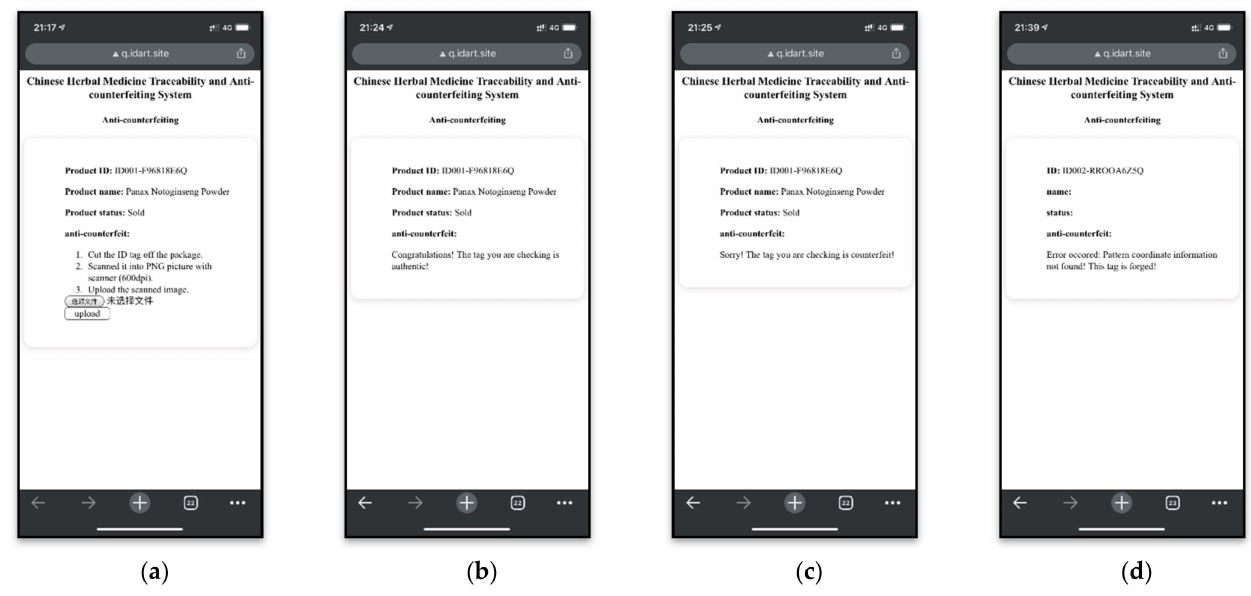
Figure 15. Anti-counterfeiting web page of the prototype system. ( a ) Scan image uploading page. ( b – d ) Anti-counterfeiting results for the authentic, counterfeit, and forged tags,